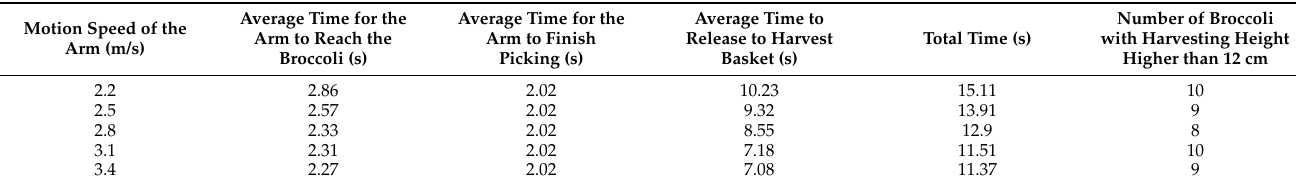
Table 4. Average harvesting time under different movement